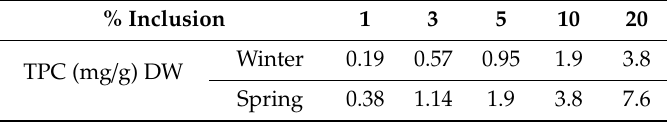
Figure 6. Change in in vitro DM digestibility (IVDMD) of a commercial pig feed when di ff erent percentages of A. nodosum were added from samples collected in Jan and May. * = p < 0.05 between control and % inclusion; (cid:63) = p < 0.05 between pairs. Table 2. Concentration of phlorotannins at each inclusion